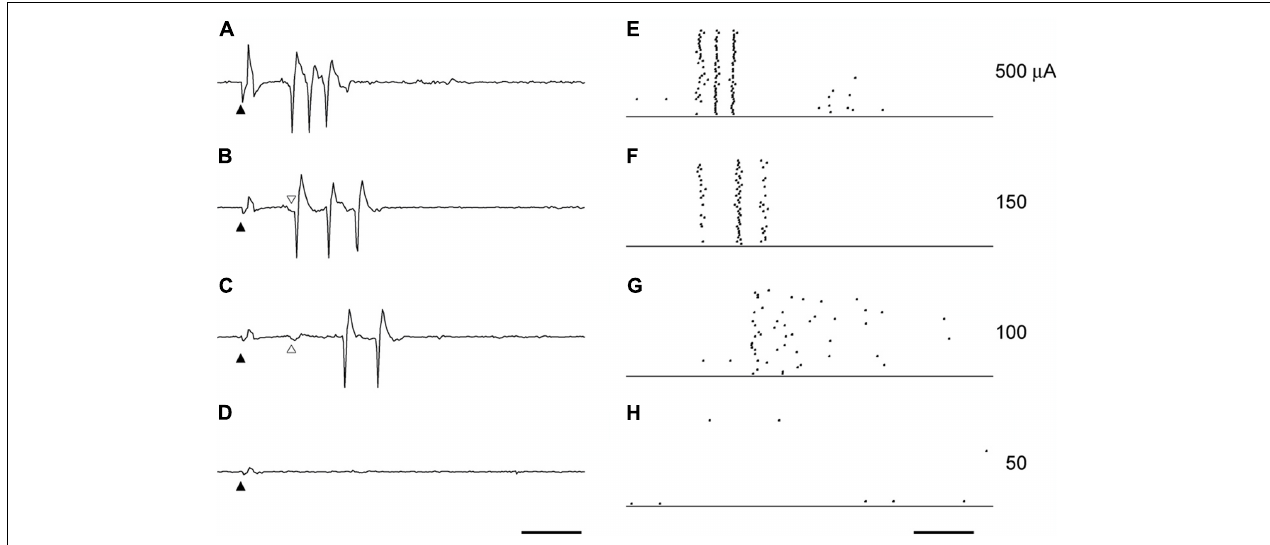
FIGURE 2 | The effect of current intensity on the spikes triggers the first burst. The example waveforms (A–D) and the raster plots (E–H) by the STS of various intensities were obtained from the same unit to Figure 1 . The current intensities were 500 µ A (A,E) , 150 µ A (B,F) , 100 µ A (C,G) , and 50 µ A (D,H) . Solid arrowheads indicate the timing of STS. Scale bars, 5 ms. Following the decrease in current intensity, the decrease of the spike discharges (F,G) an increase in the spike intervals (E,F) was observed. The latency of the first spike in (A,B) was not affected by the current intensity. The first spike usually followed the small deflection indicated by open arrowheads in (B,C) . This small deflection was still evoked with the same latency, even when the first spike disappeared with the STS of 100 µ A (C) .